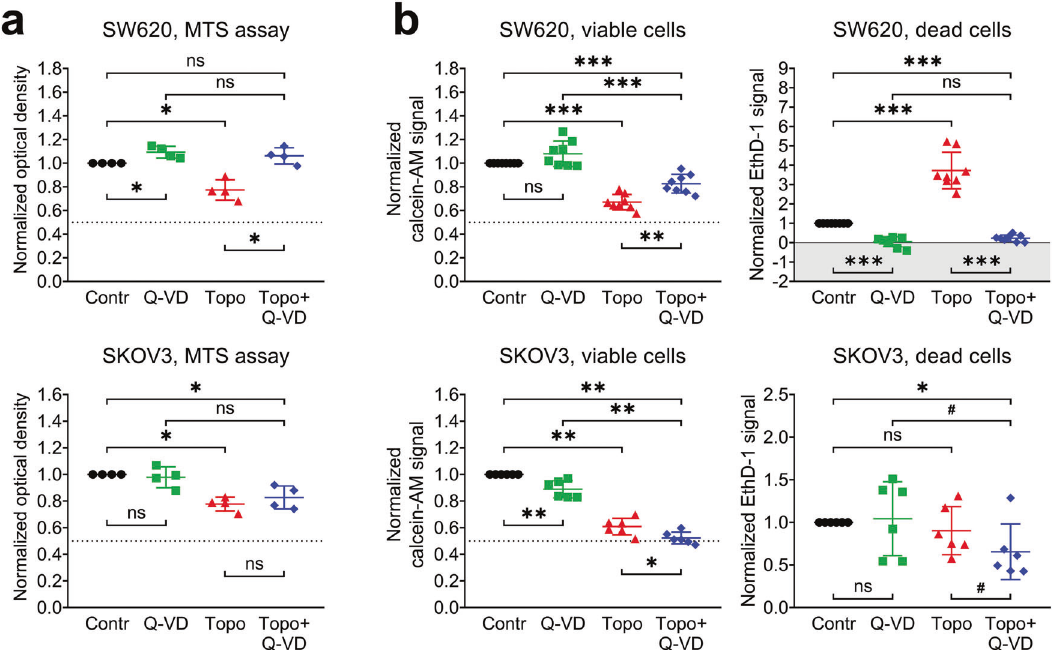
Fig. 3 Cytotoxic and cytostatic effects of topotecan treatment in SW620 and SKOV3 cell lines (microplate-based assays). The cells were treated with topotecan (20 nM for SW620, 70 nM for SKOV3) in the presence or absence of 25 μ M of Q-VD. a Relative optical density values obtained via the MTS assay. The data are normalized to the respective “ Contr ” samples; the lines and whiskers indicate mean ± standard deviation ( N = 4). The dashed lines indicate a 50% reduction in the MTS signal. b Calcein-AM and EthD-1 signals were obtained via the LIVE/ DEAD assay. The data are normalized to the respective “ Contr ” samples; the lines and whiskers indicate mean ± standard deviation ( N = 8 for SW620, N = 6 for SKOV3). The dashed lines indicate a 50% reduction in the calcein-AM signal, and the gray area indicates the EthD-1 signal that is below the average background level. “ Contr ” – control samples; “ Topo ” –